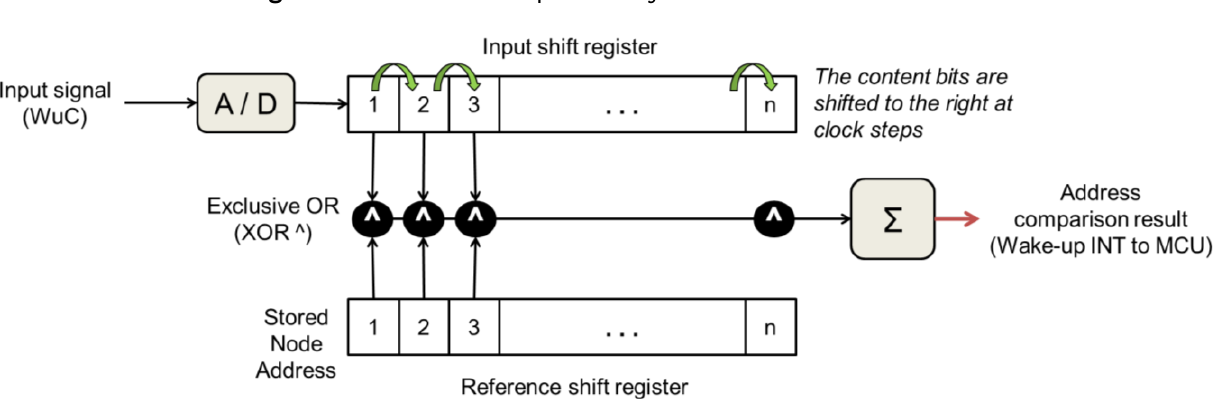
Figure 19. Address comparison by means of bit